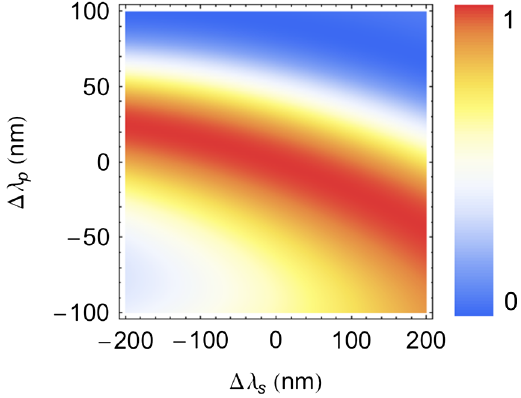
FIG. 4. Phase mismatch-induced efficiency factor sinc 2 ð (cid:1) kL= 2 Þ as a function of signal and pump wavelength, when a 1 mm long BBO crystal is optimized for the type I mixing process 2000 nm þ 1333 nm ¼ 800 nm .